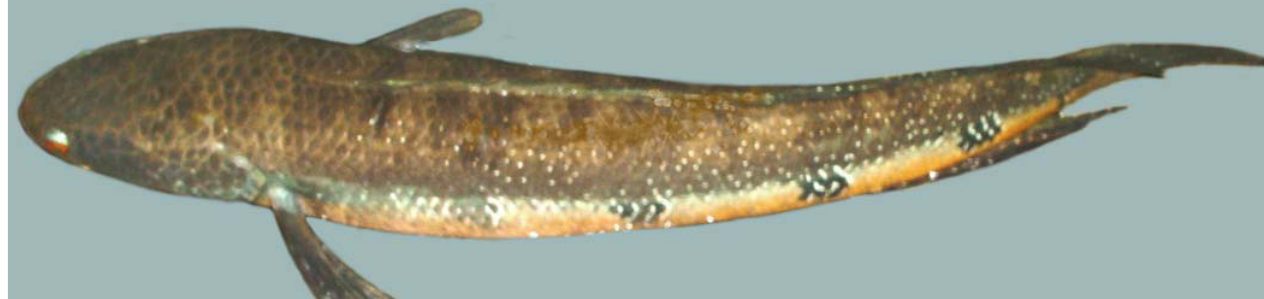
Image 7. Side view of Channa maruliu s (GUMF